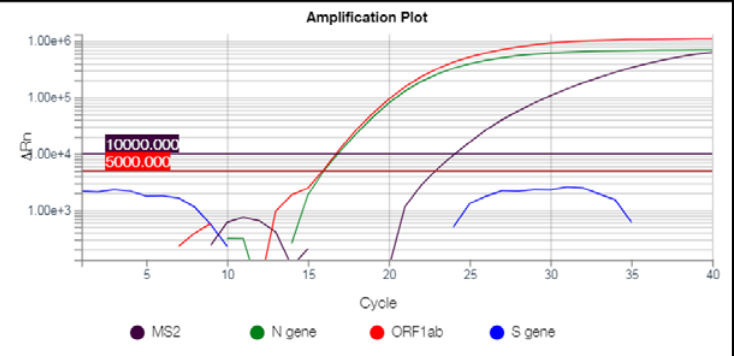
Figure 1. Amplification plot of a suspect omicron variant carrier.The amplification plot related to a sample suggestive of being oV is shown, as visualized on QuantStudio DA2 Software. In particular, only N and Orf1ab genes were successfully amplified, whereas the amplification of the S gene failed. The resulting Ct values are calculated based on the threshold of 5000.00 ∆ normalized reporter (Rn) value according to manufacturer’s instructions. The MS2 represents the probe for the detection of the internal control provided by the kit and its related Ct is obtained based on the threshold of 10,000.00 ∆ Rn, as indicated by the manufacturer.